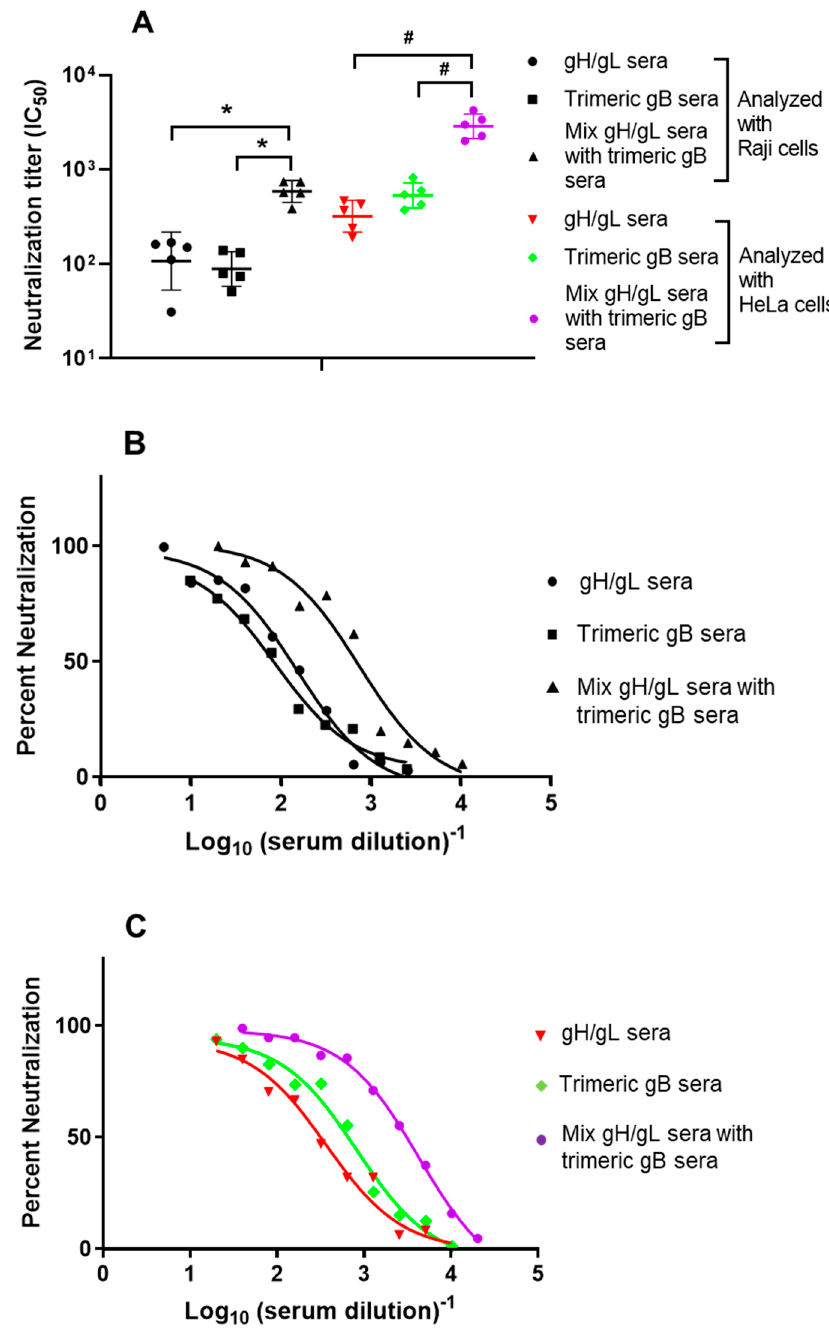
Figure 2. Mixing of the sera from rabbits immunized with EBV gH/gL and the sera from rabbits immunized with EBV trimeric gB in vitro showed synergistic neutralizing activity preventing EBV infection of the B lymphoma cell line Raji and the epithelial cell line HeLa. Day 52 immune sera from rabbits ( n = 5) subcutaneously immunized three times with 25 µ g of recombinant EBV gH/gL or EBV trimeric gB adjuvanted with alum + CpG-ODN were heat-inactivated. EBV gH/gL immune sera were mixed with EBV trimeric gB immune sera in equal volume. ( A ) Serum IC 50 neutralizing titers were determined using Raji/HeLa cells and the EBV strain B95-8 GFP as indicated. Significance *, # p < 0.05 compared to the EBV neutralizing activities of the sera from rabbits immunized with individual envelope proteins. ( B ) Calculation of IC 50 by non-linear regression analysis using Raji cells and EBV strain B95-8 GFP. ( C ) Calculation of IC 50 by non-linear regression analysis using HeLa cells and EBV strain B95-8